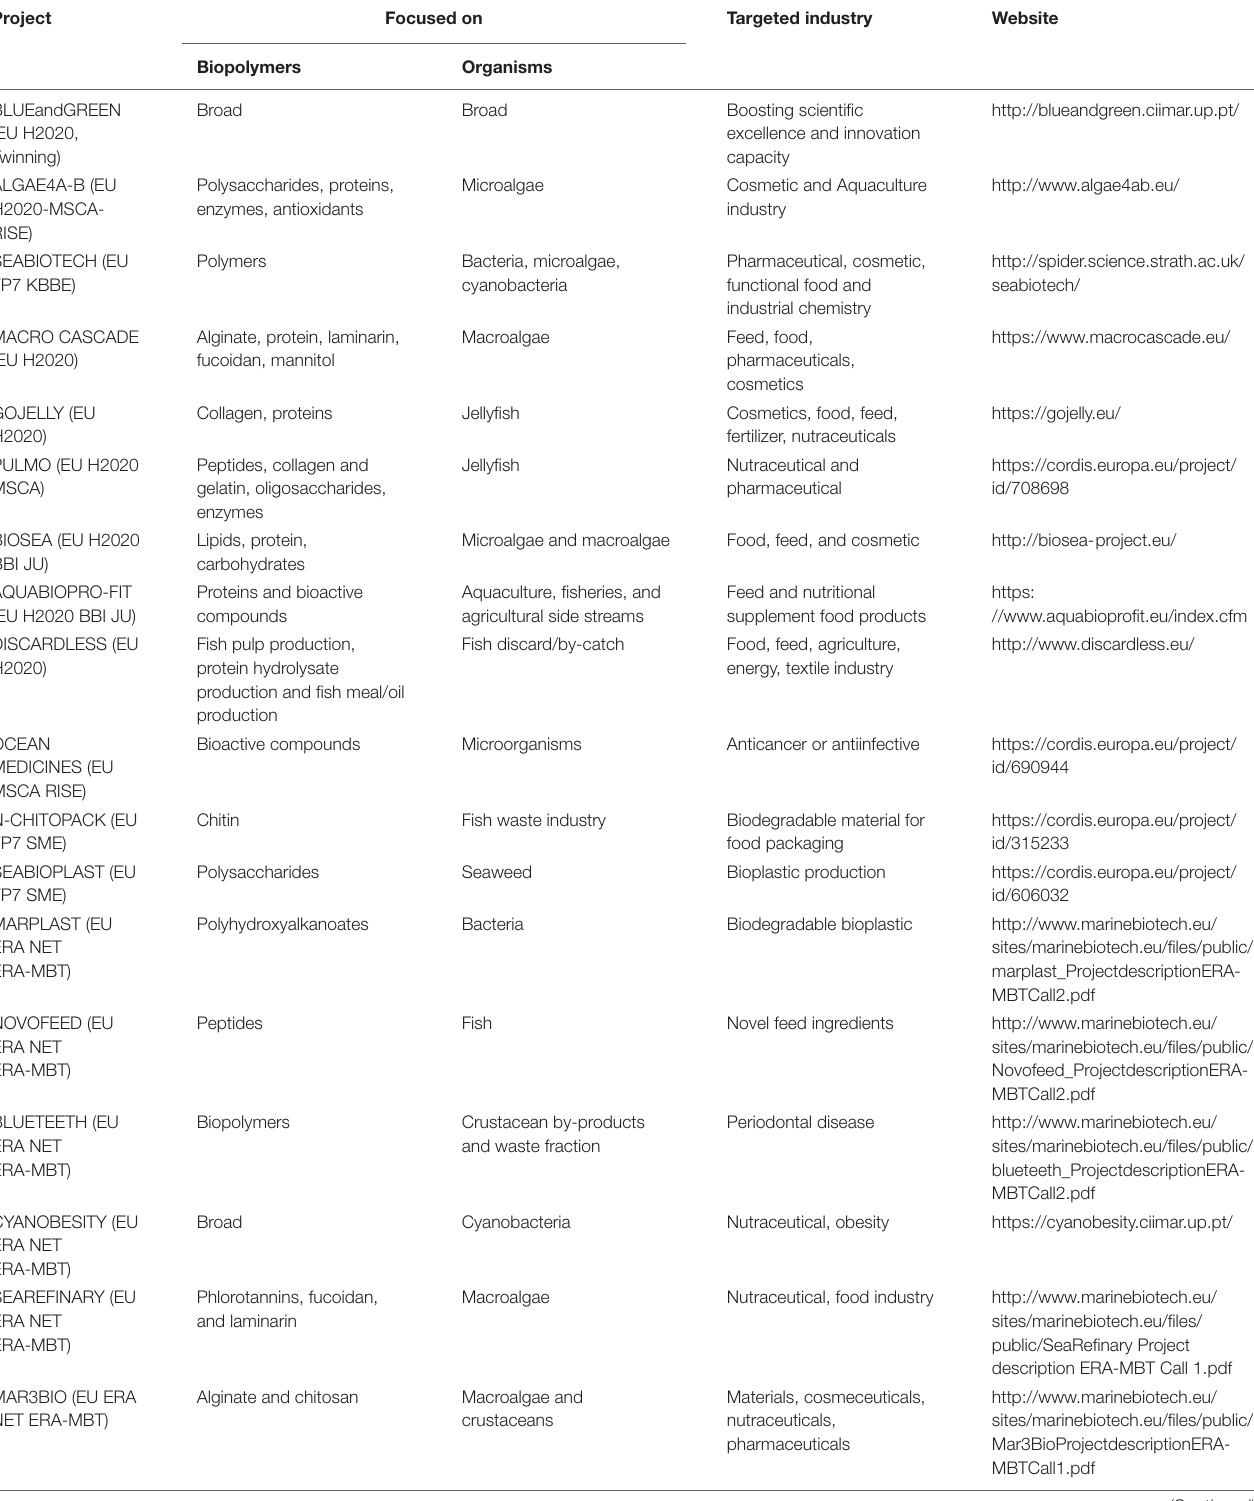
TABLE 4 | Overview of the EU funded international projects on marine biotechnology.